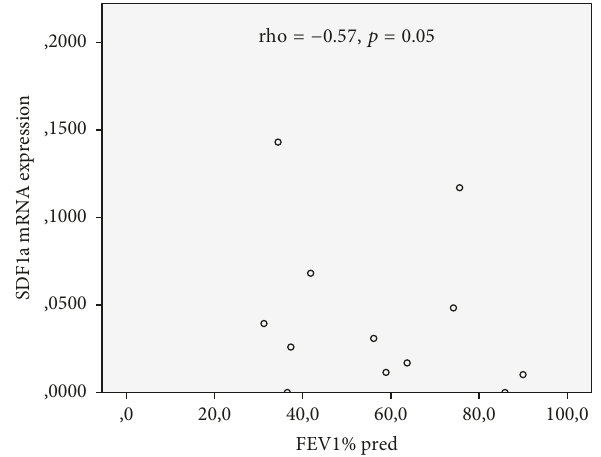
Figure 3: Correlations between SDF1a levels and severity of